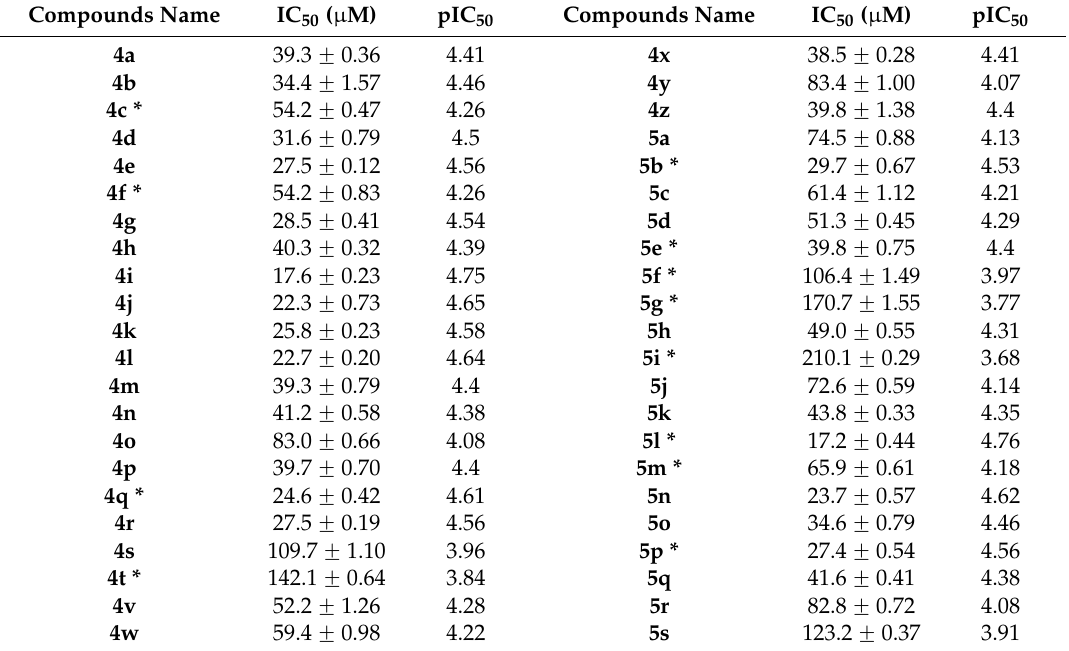
Table 4. In vitro activity of urease inhibition of compounds 4a-z and 5a-s